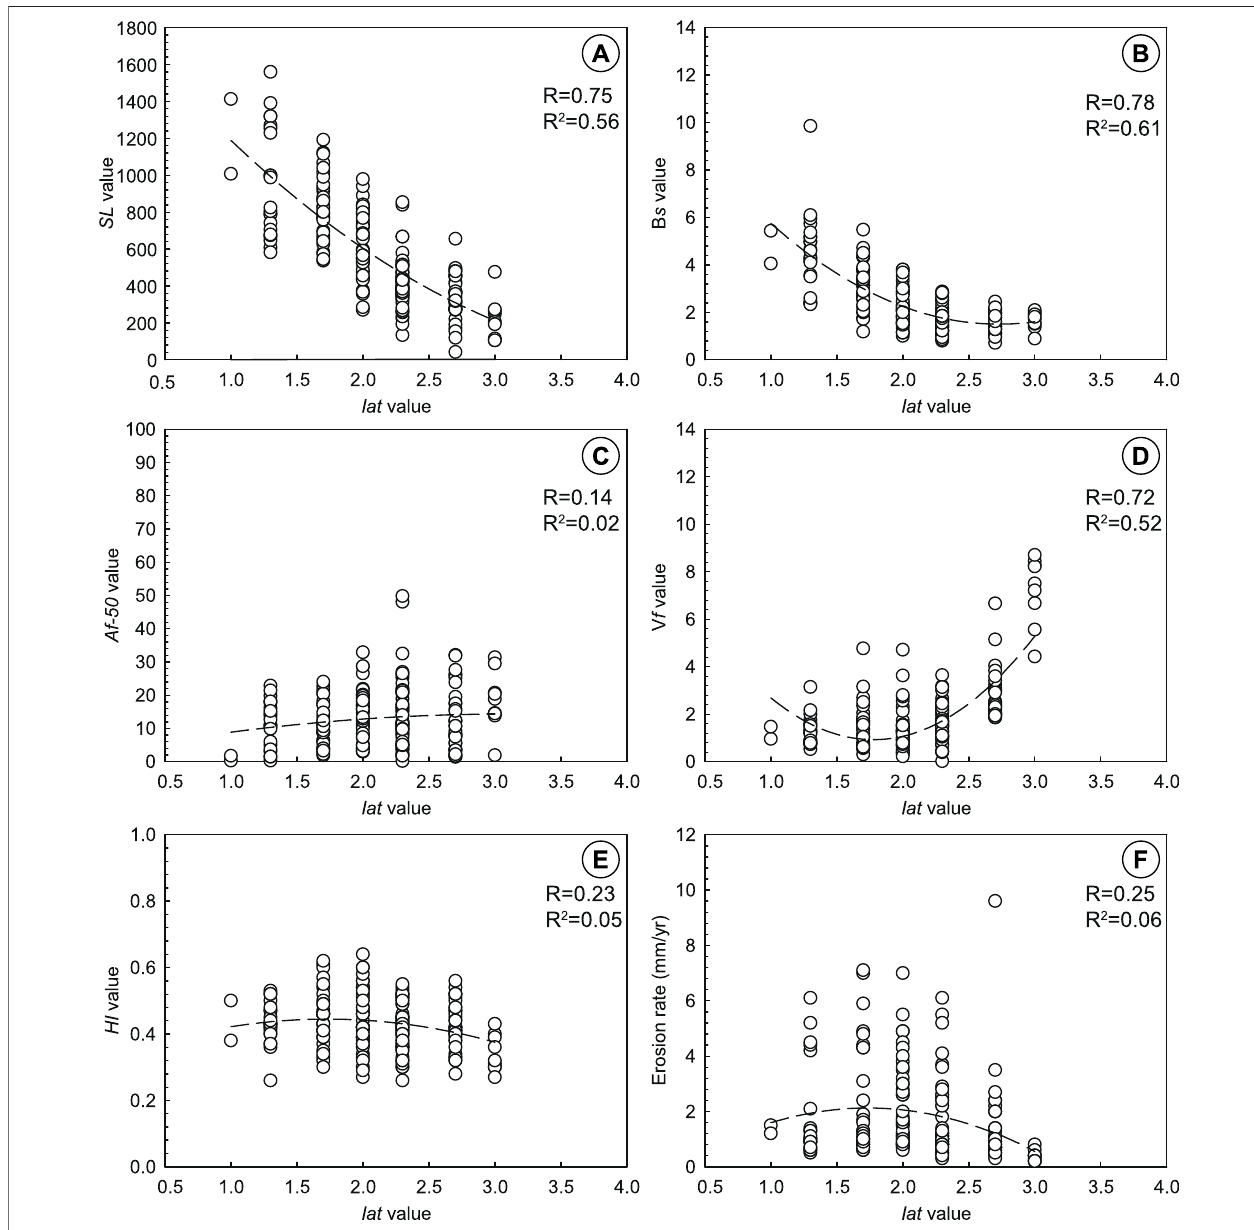
FIGURE7| Correlationof Iat valueswithmultiplemorphologicparametersusingpolynomial,quadraticdynamic fi ttinginSigmaplot.Best- fi tsolutions(Rand R 2 )for correlation between Iat values and (A) stream length-gradient index ( SL ), (B) drainage basin shape ( Bs ), (C) asymmetric factor ( Af-50 ), (D) ratio of valley- fl oor width to valley height ( Vf ), (E) hypsometric integral ( HI ) and (F) erosion rate.